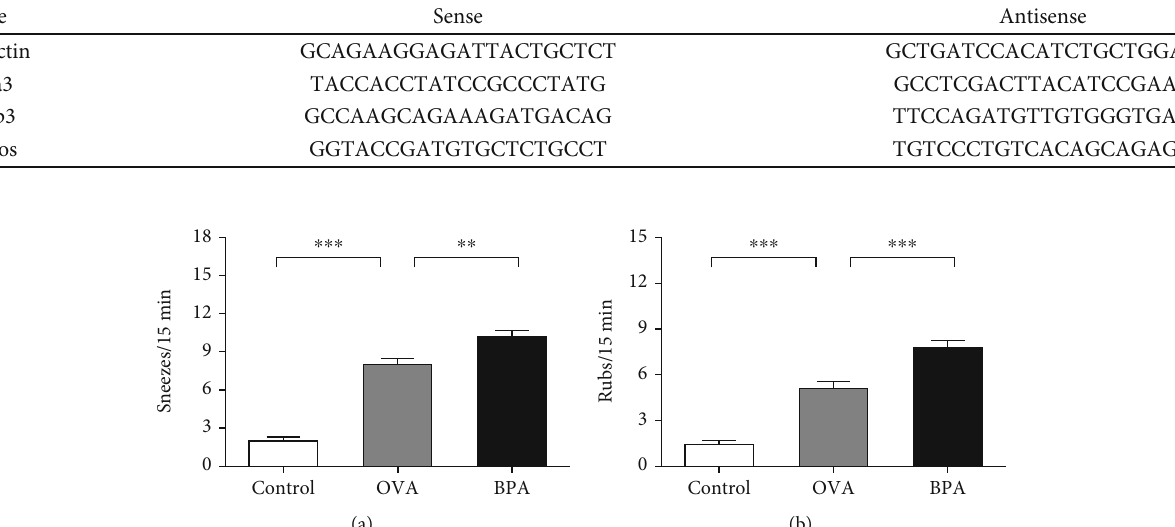
Figure 2: The numbers of (a) sneezes and (b) nasal rubs for each mouse were counted over 15min from the last intranasal OVA challenge. Data are expressed as means ± SEM ; n = 10 in each group. ∗∗ P < 0 : 01 ; ∗∗∗ P < 0 : 001 .